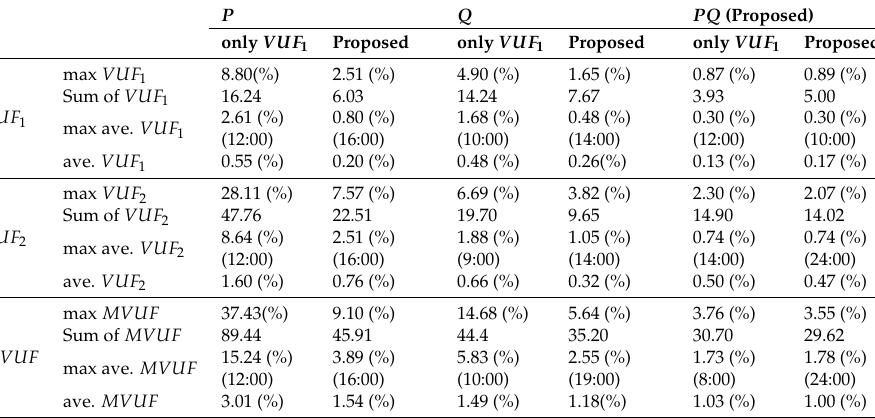
Table 3. Simulation result of each